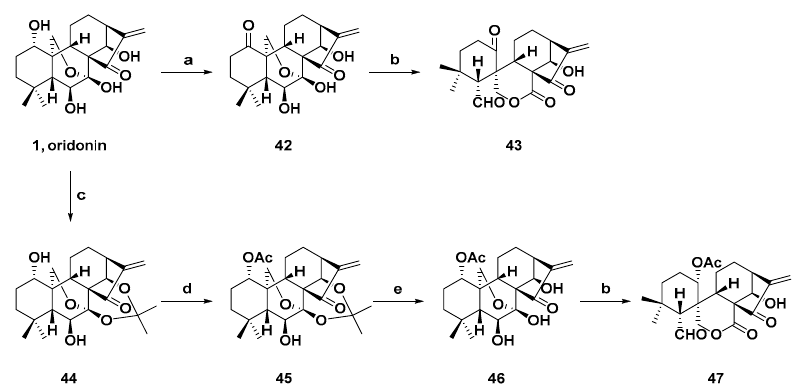
Scheme 1. Synthetic route of spirolactone-type diterpenoid skeletons from oridonin. Reagents and conditions: ( a ) Jones reagent, acetone, 0 °C; ( b ) Pb(OAc) 4 , Na 2 CO 3 , THF, rt; ( c ) 2,2-Dimethoxypropane,